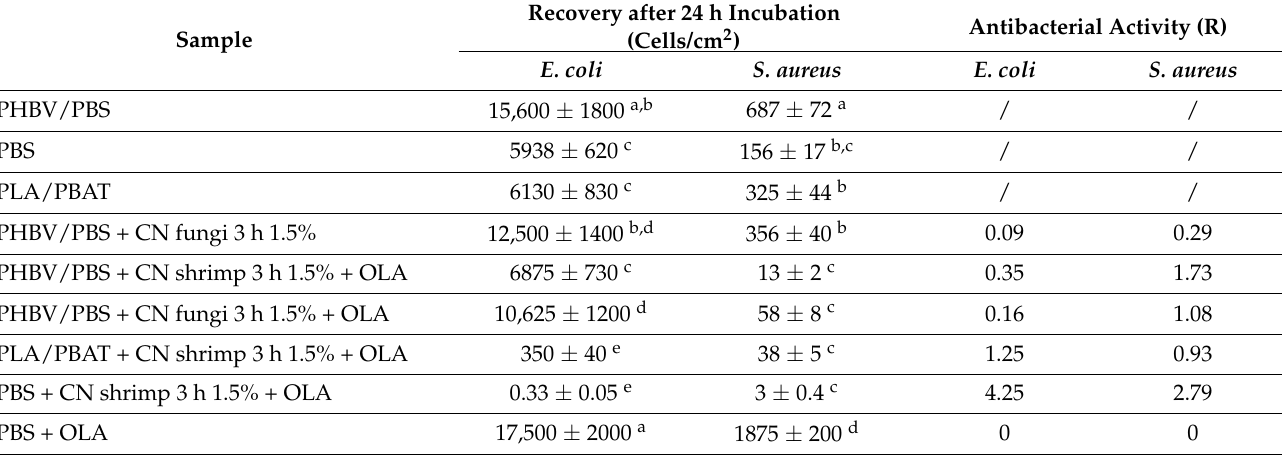
Results of antibacterial tests on films treated with chitin (Aldrich) and chitin (Aldrich) + OLA1350. For each column of results, the same letter means that values were not signifi- cantly different (confidence level